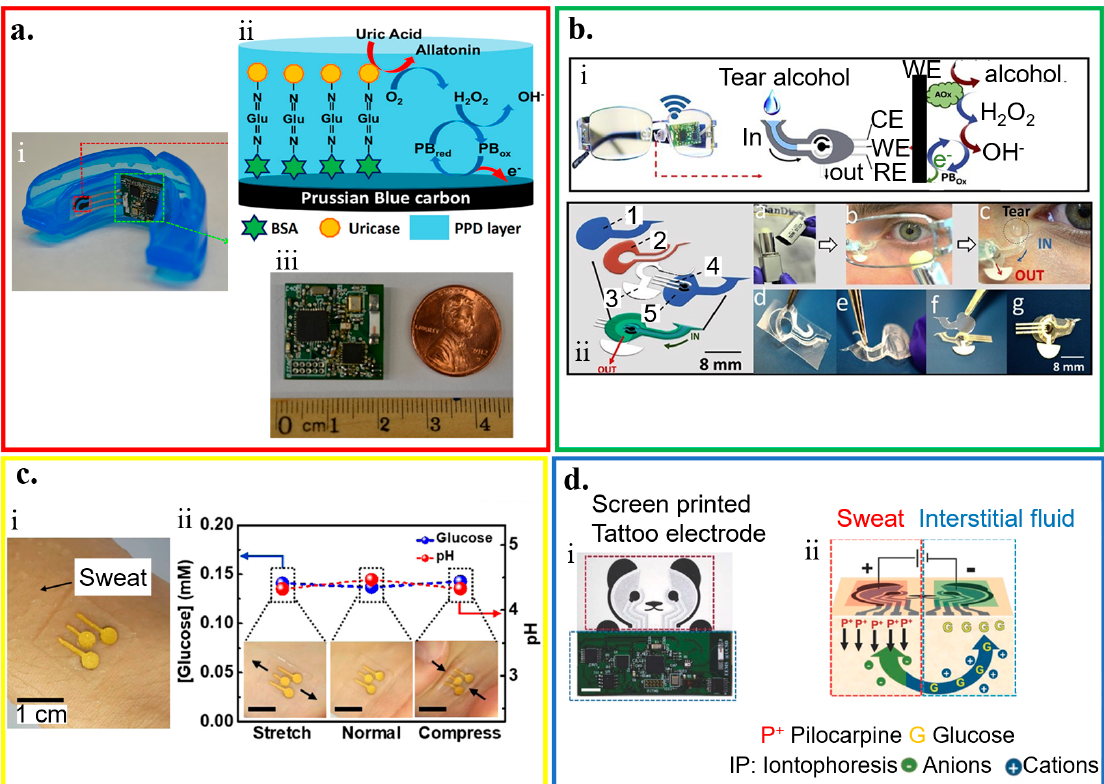
Figure 3. Application of wearable electrochemical biosensor for biofluid analysis. ( a ) Saliva analysis from (i) a mouthguard biosensor integrated with a wireless amperometric circuit board. (ii) Schematic of reagent layer of the chemically modified, printed Prussian Blue (PB) carbon working electrode containing uricase for the salivary uric acid (SUA) biosensor and (iii) optical image of the wireless amperometric circuit board; reproduced with permission from [76], Copyright 2015, Elsevier. ( b ) Tear analysis by (i) an eyeglasses platform consisting of wireless electronics and a fluidic device with (ii) its exploded view that shows (1) top polycarbonate membrane, (2) double-adhesive spacer, (3) paper outlet, (4) electrochemical (bio)sensor, and (5) bottom polycarbonate membrane; reproduced with permission from [93], Copyright 2019, Elsevier. ( c ) Sweat analysis from (i) an electrochemical biosensor attached to the skin wet with sweat, along with (ii) its performance under mechanical deformation;